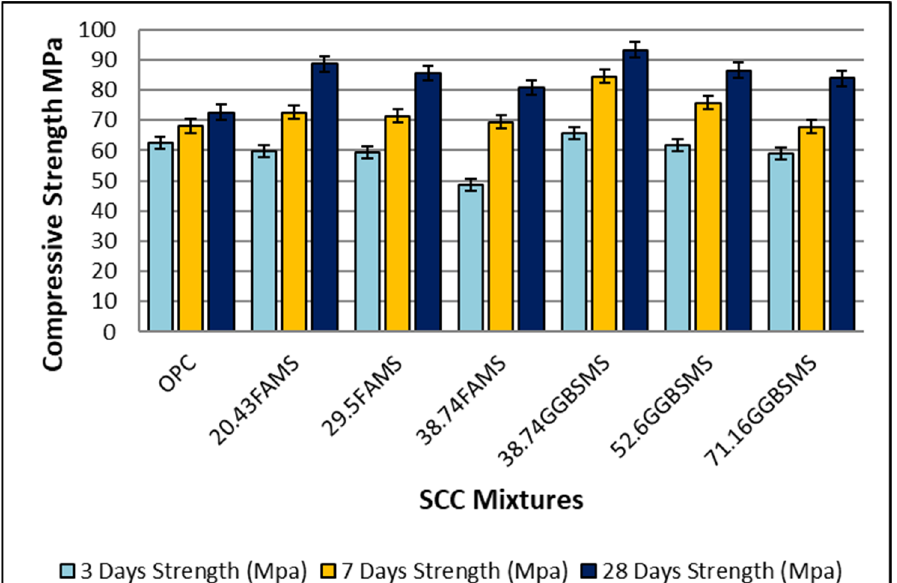
Figure 14. Compressive strength test results.